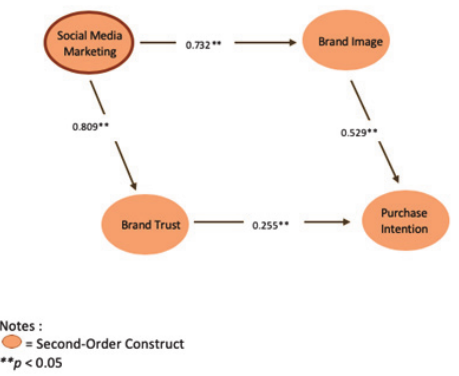
Fig. 2. Conceptual Model